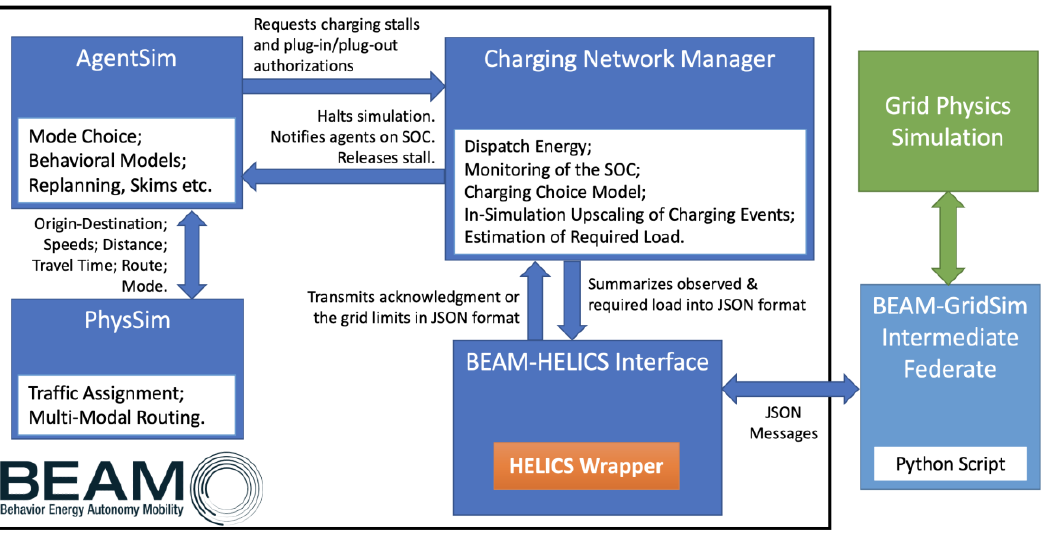
Figure 2. The co-simulation block diagram of the transportation model BEAM configured for this work. this